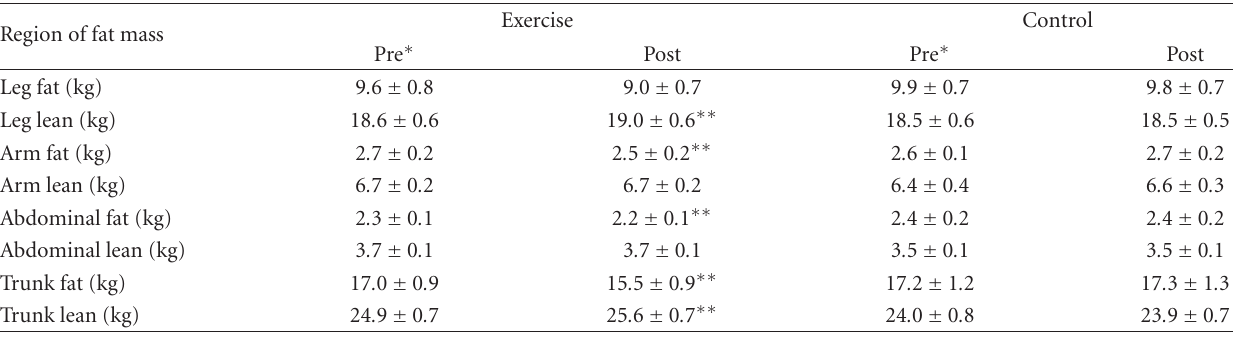
Table 2: Regional changes in body composition for the high-intensity intermittent exercise and no exercise control groups ( N = 38; mean and standard error).